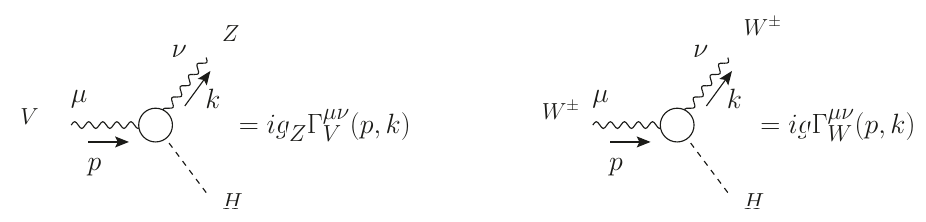
Figure 1 . Feynman rules for the HZV ( V = Z; (cid:13) ) vertex and the HWW